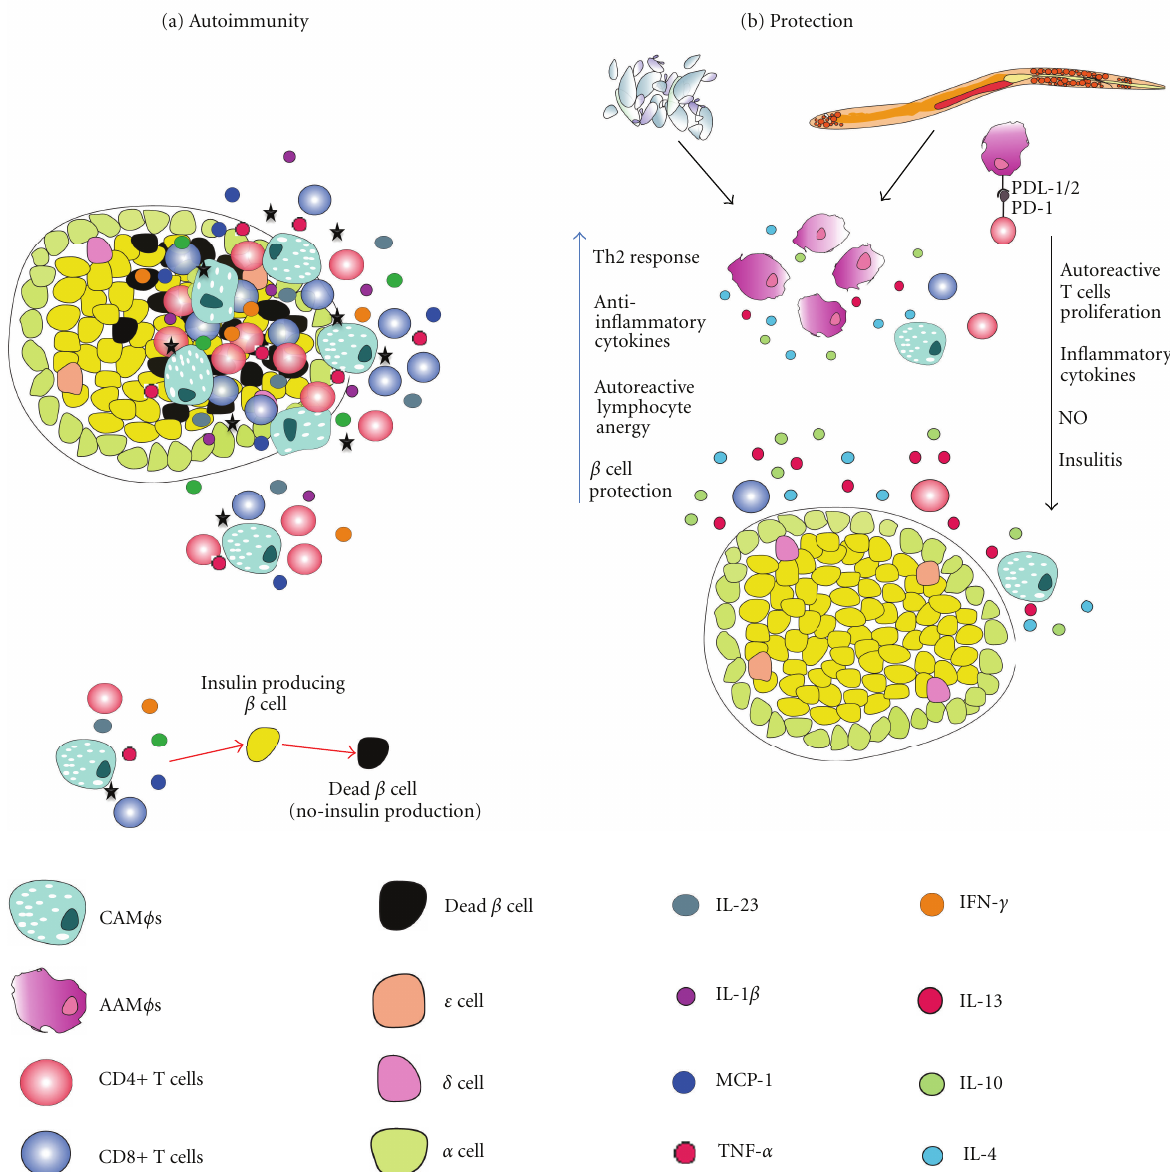
Figure 1: (a) In type 1 diabetes, CAM ϕ s and autoreactive T cells are the first cells that infiltrate the islets of Langerhans and release proinflammatory cytokines and NO, which induce β cell apoptosis or necrosis; (b) the release of anti-inflammatory cytokines, AAM ϕ induction and PD-1/PD-ligand-dependent lymphocyte anergy induction by helminths, the antigens of which have the ability to decrease NO, as well as proinflammatory cytokine, secretion, thereby reducing insulitis and β cell death.